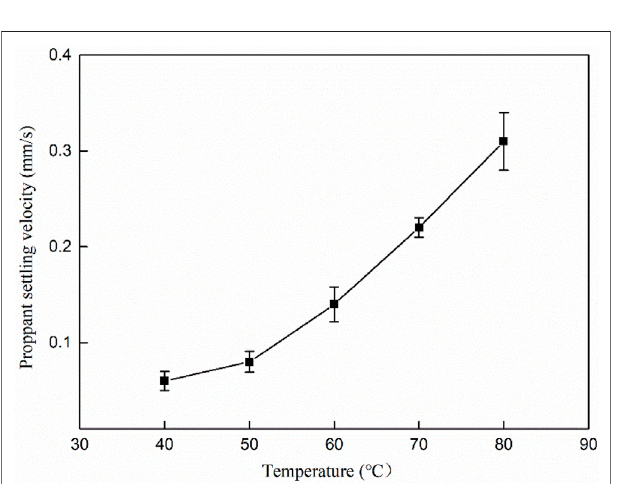
FIGURE 11 | Settling curve of proppant in the MSA/CTAB mixed system.